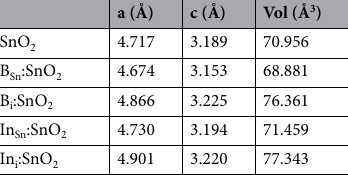
Table 1. The calculated lattice constants and cell volumes for all the